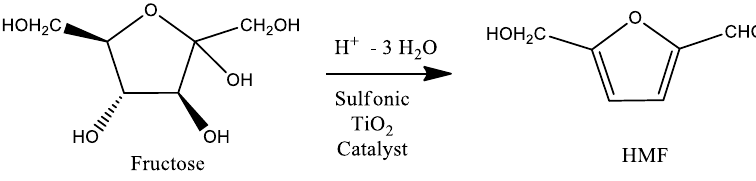
Figure 2. Fructose dehydration to 5-HMF.